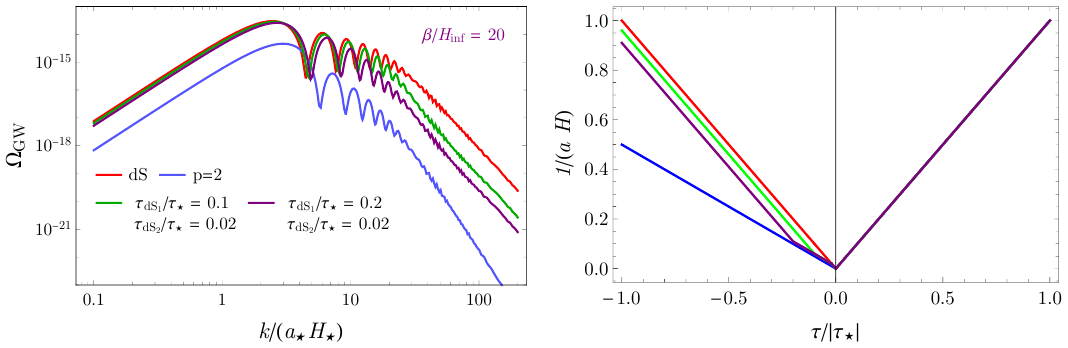
Figure 6 . The left panel shows observed GW spectrum for different k modes in several different inflationary scenarios. The right panel shows the evolution of the co-moving horizon as a function of conformal time. Different colors denotes different cosmic evolution histories before reheating, including quasi-de Sitter (red), t 2 inflation (blue), and dS- t p -dS scenarios with different parameters (green and purple lines).